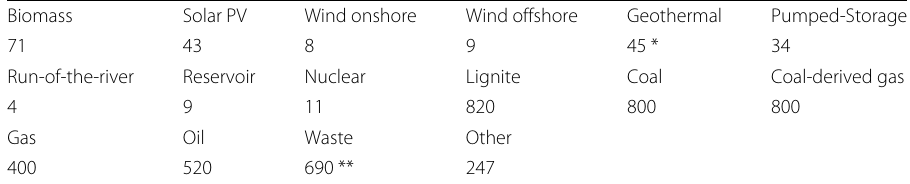
Table 1 Life-cycle GHG emission for power plants, expressed in gCO 2 eq/kWh Biomass Solar PV Wind onshore Wind offshore Geothermal Pumped-Storage 71 43 8 9 45 * 34 Run-of-the-river Reservoir Nuclear Lignite Coal Coal-derived gas 4 9 11 820 800 800 Gas Oil Waste Other 400 520 690 **